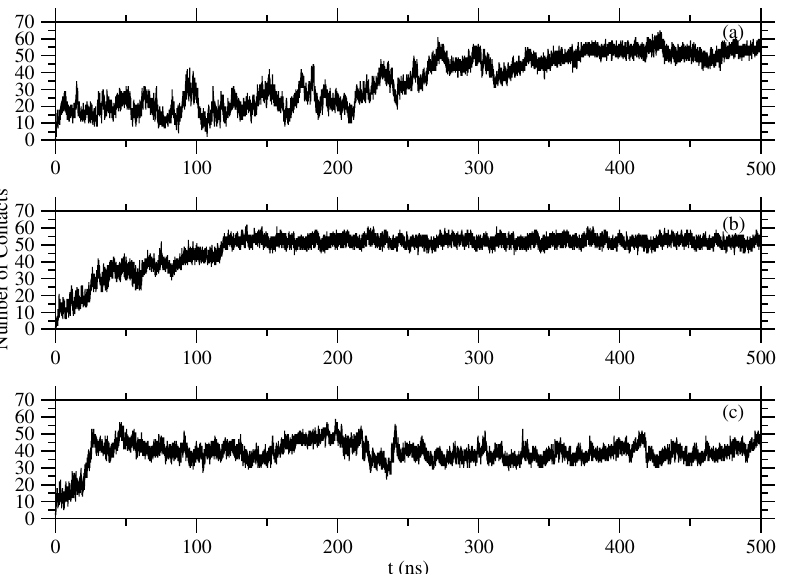
Figure 6. Number of close contacts between two ionized atoms of ( a ) Phe, ( b ) Tyr, and ( c ) Trp